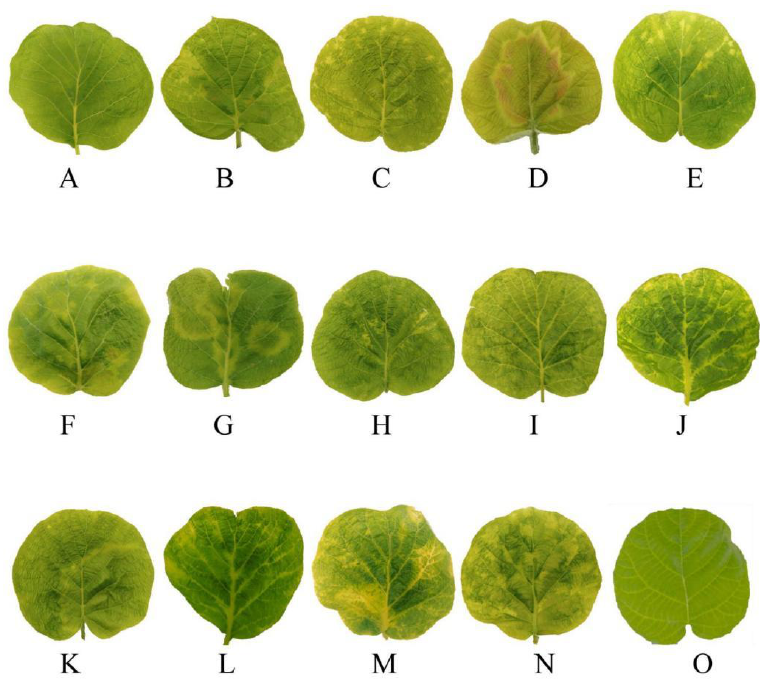
Figure 1. Symptoms of single and co-infections of Hongyang kiwifruits in the Sichuan province with AcVA, AcVB, AcCRaV, and CMV. Note: ( A ), AcVA; ( B ), AcVB; ( C ), AcCRaV; ( D ), CMV; ( E ), AcCRaV + AcVA; ( F ), AcCRaV + CMV; ( G ), AcVA + CMV; ( H ), AcVB + AcCRaV; ( I ), AcVB + CMV; ( J ), AcVA + AcVB; ( K ), AcVA + AcCRaV + CMV; ( L ), AcVA + AcVB + AcCRaV; ( M ), AcVB + AcCRaV + CMV; ( N ), AcVA + AcVB + AcCRaV + CMV; ( O ), normal leaves.